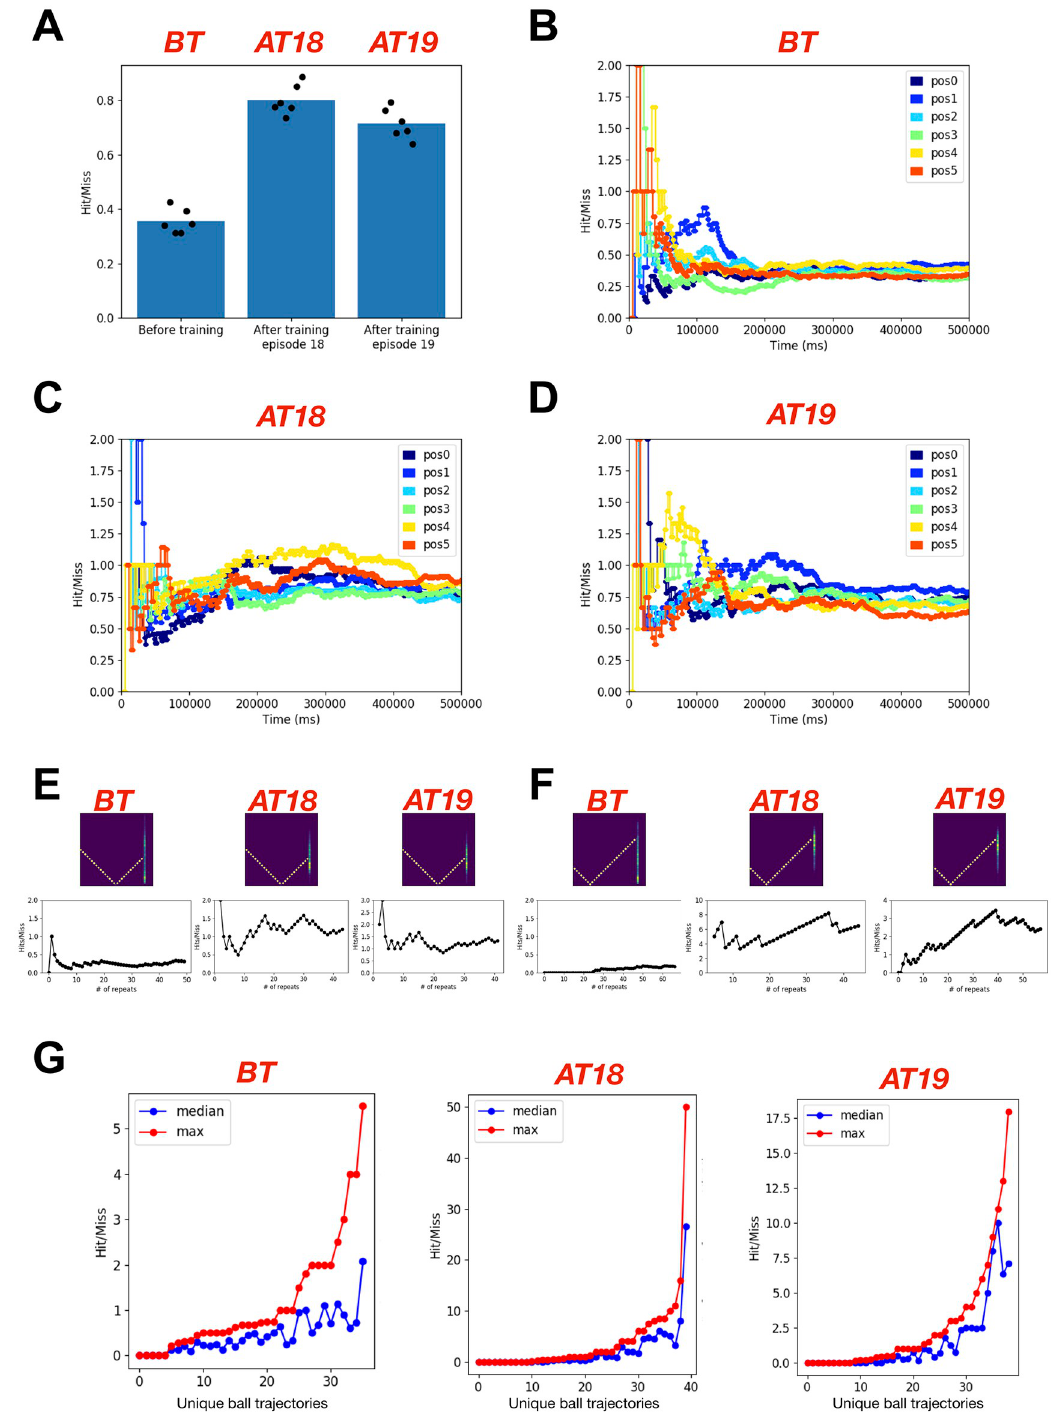
Fig 4. The feedforward spiking neuronal network model sustained its performance after learning. A) The bar plot shows the mean (n = 6) performance (Hit/Miss) of the model before training (using initial weights), after training episode 18 and after training episode 19. For each condition, 6 different initial positions of the racket and the ball were used to evaluate and compare the performance of the model after learning. Each simulation was run for the duration of 500 sec. B) The temporal evolution of the cumulative performance (Hit/Miss) for the model before learning (using initial weights for synaptic connections). The traces in different colors show performance for different initial positions of the ball and the racket. C) Same as in B using fixed weights